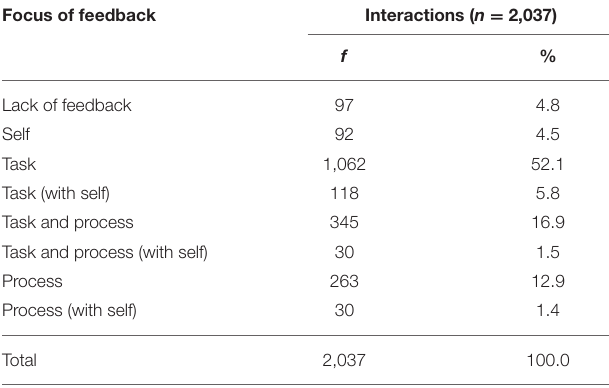
TABLE 4 | Frequency and percentages of the focus of feedback from the observed interactions. Focus of feedback